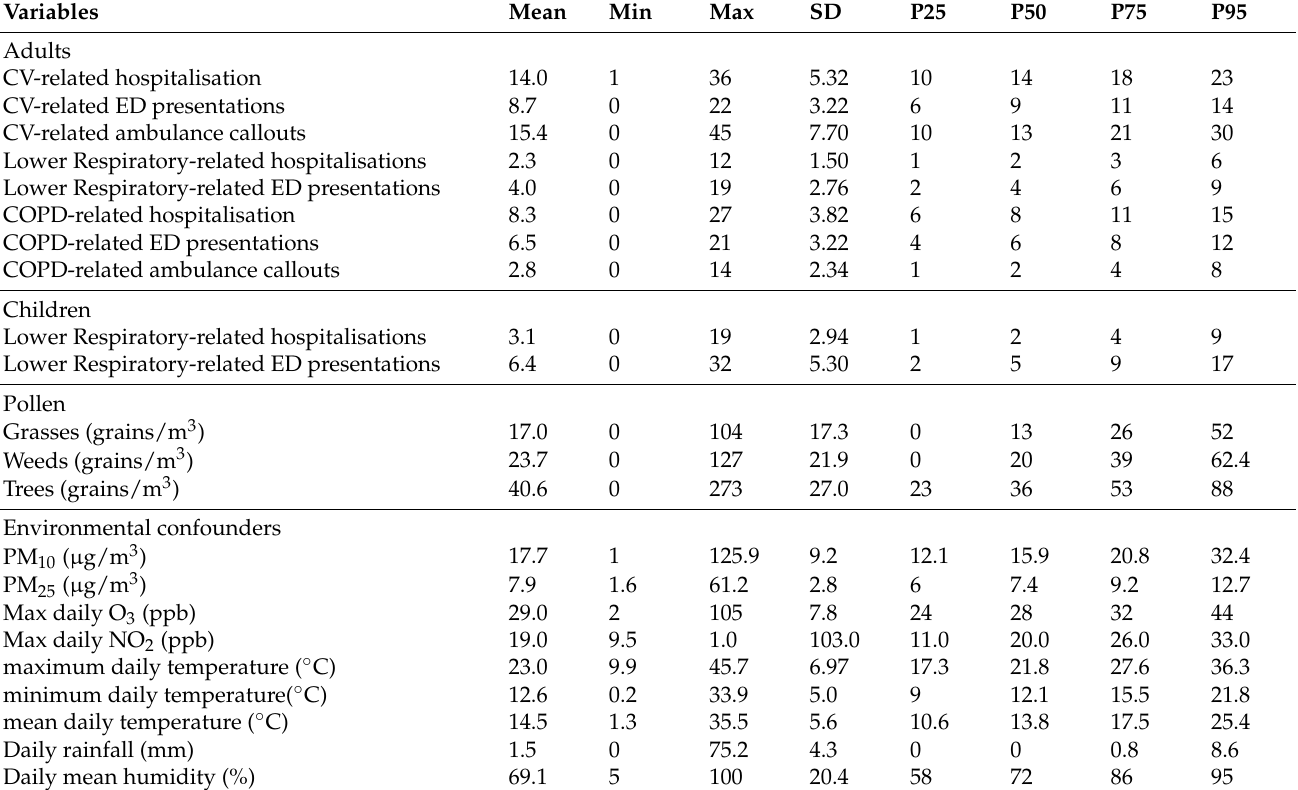
Table 1. Descriptive data on health outcomes, pollen, and environmental confounders. (Number of days of observation for hospitalisation n = 5478; ED = 5113; ambulance n = 4935; for pollen and environmental confounder n =